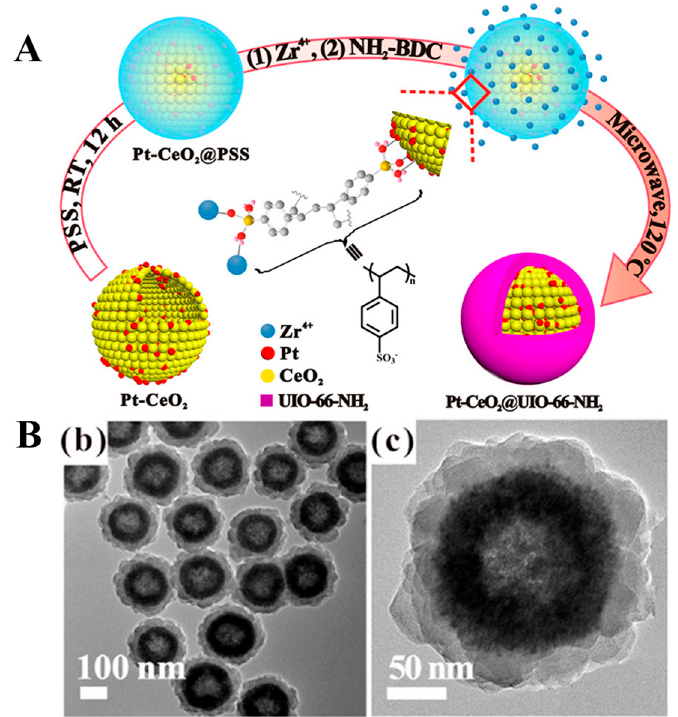
Figure 7. ( A ) Schematic Illustration for the Formation of PtCeO 2 @UiO-66-NH 2 . ( B ) TEM images of Pt-CeO 2 @UiO-66-NH 2 ( b ) Scale bar 100 nm and ( c ) 50 nm. Reproduced with permission from Ref. [115]